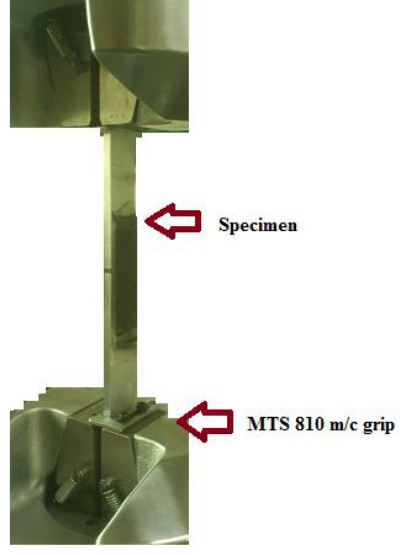
Figure 3. Specimen under tensile test.